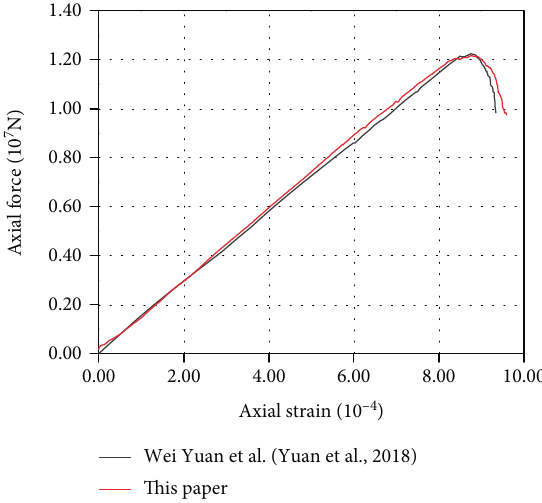
Figure 6: Comparison of Brazilian splitting test results of sandstone [35].